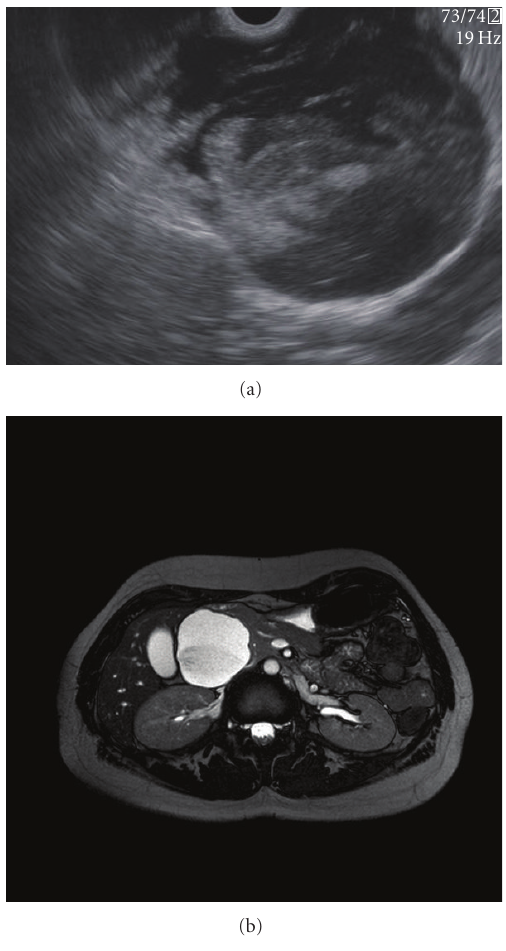
Figure 3: (a) EUS image of a malignant IPMN in the head of the pancreas. (b) MRI image of a malignant IPMN in the head of the